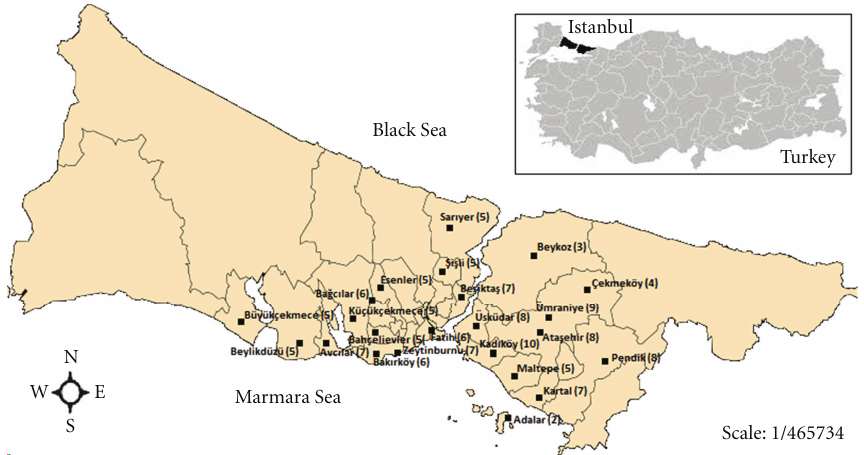
Figure 2: Map of samples collected in Istanbul, Turkey.